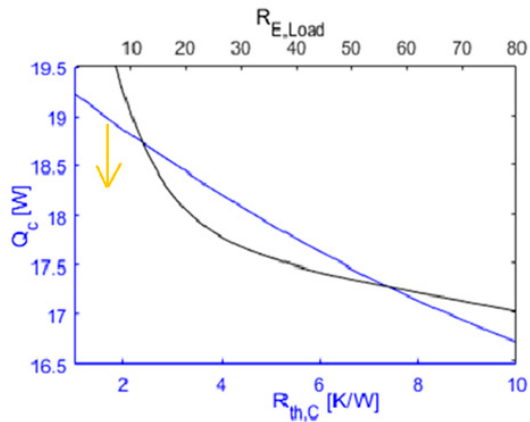
Figure 12. The effect of electrical load and thermal resistance of cold side on dissipated heat at cold